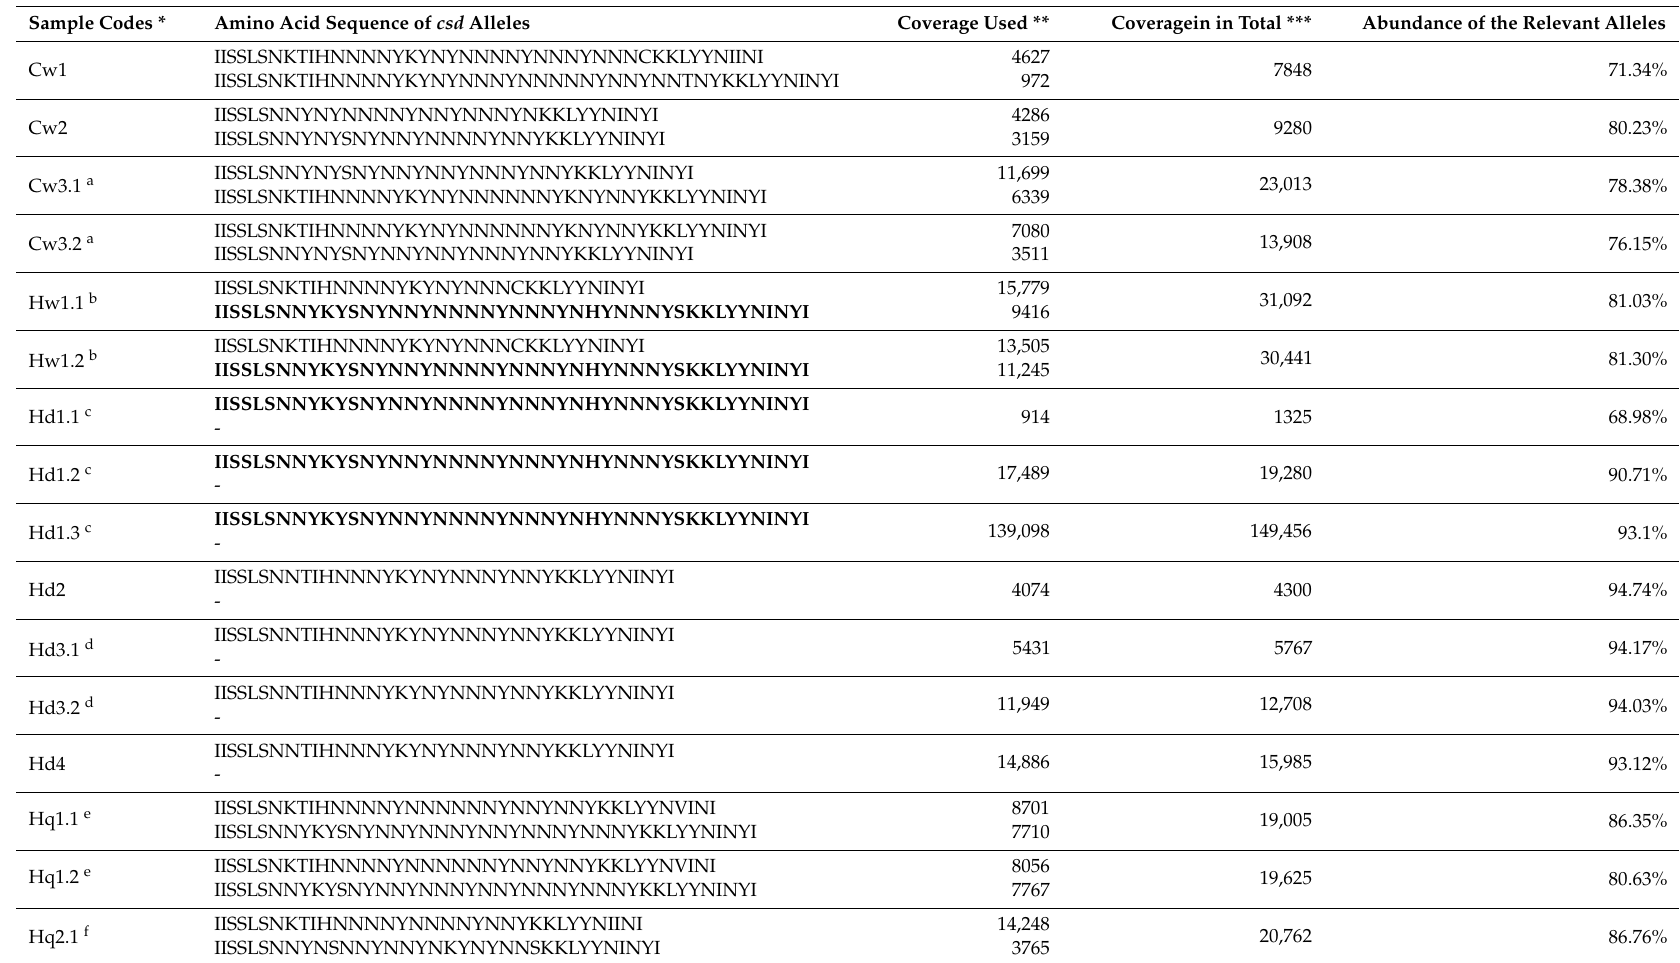
Table 2. Amino acid sequences of csd sex alleles isolated bee samples can be tracked in